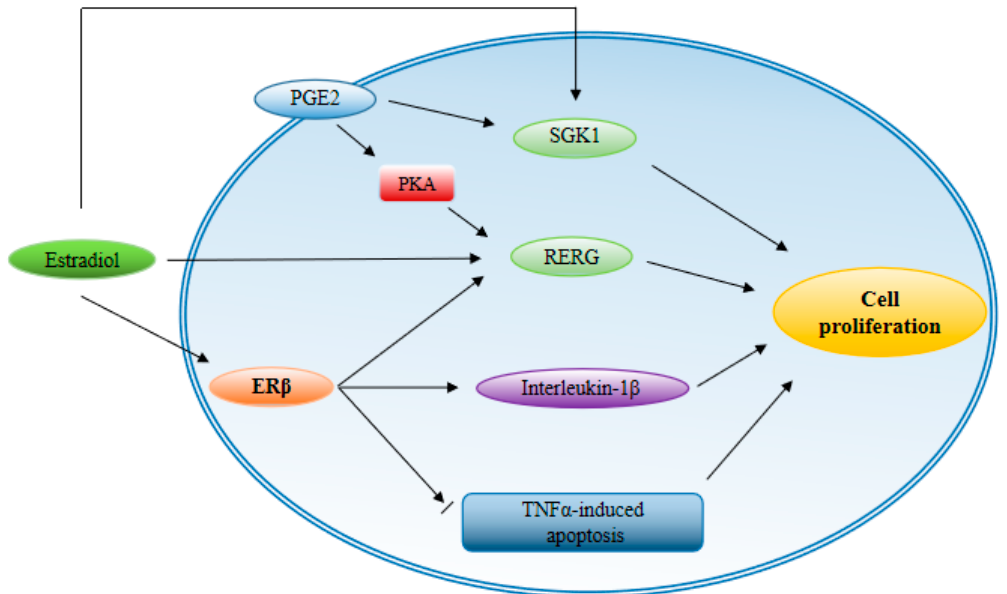
Figure 2. Expression of ER β in endometriosis. ER β mainly participates in endometriosis through the following ways: Inhibiting TNF α -mediated apoptosis, inducing an increase in interleukin-1, and co-stimulating Ras-related and estrogen-regulated growth inhibitor (REGE) expression with prostaglandin E2 (PGE2) under the action of estradiol. In addition, serum and glucocorticoid-regulated kinases (SGK1) is a co-targeting target of PGE2 and estradiol. These pathways lead to proliferation of endometriosis cells.